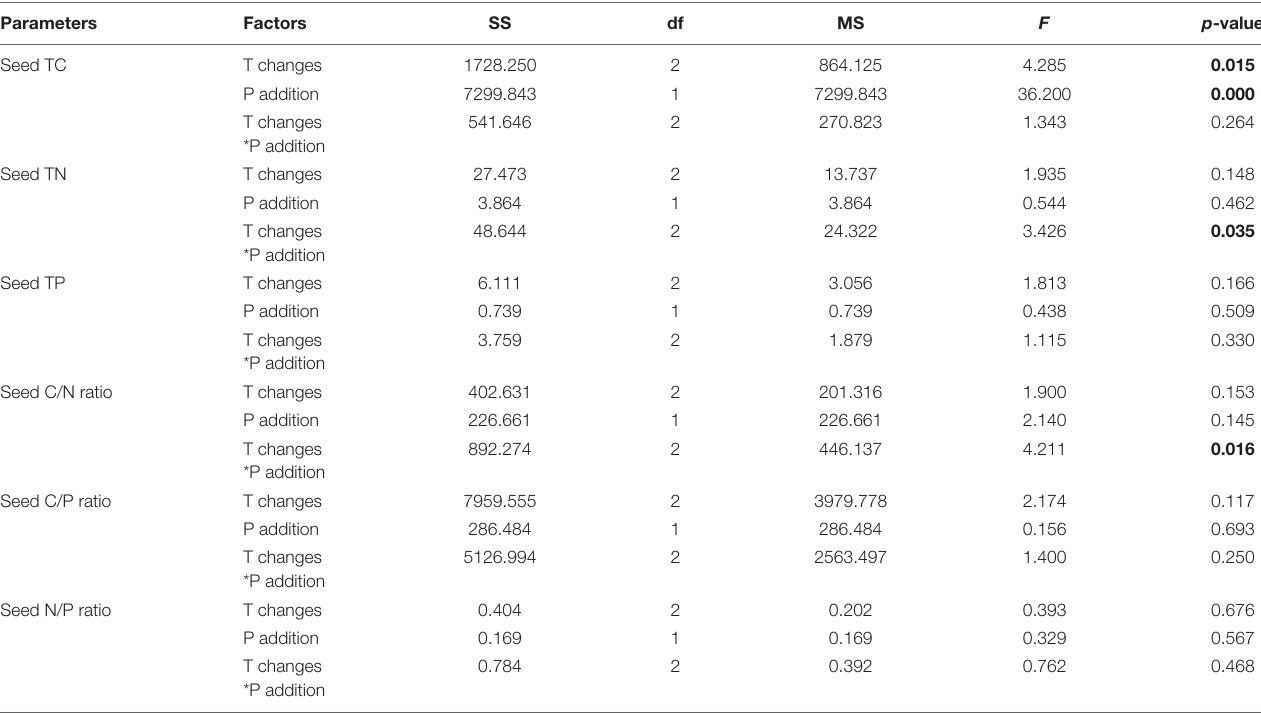
Bold numbers indicate significant differences (p < 0.05). *Meant